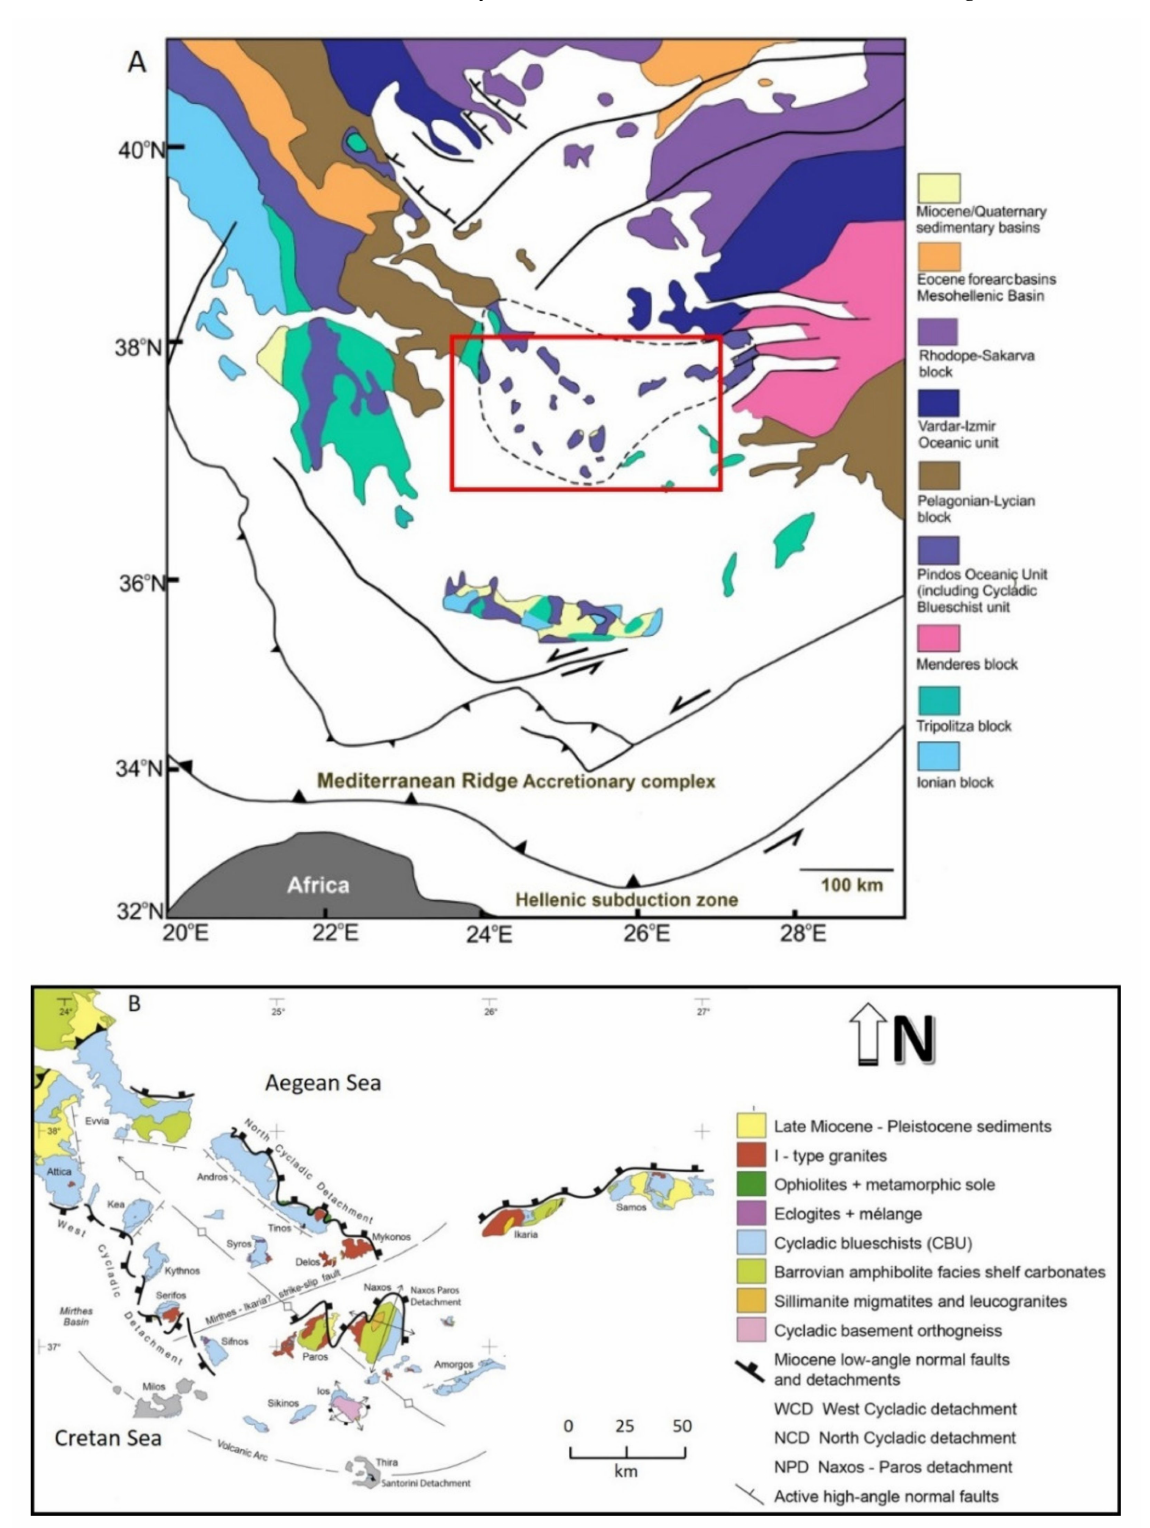
Figure 3. ( A ). A simplified tectonic map showing the major tectonic zones above the Hellenic subduction zone of the Aegean region (modified after [28,29]), ( B ). Simplified geological map of the Attic-Cycladic Crystalline Belt, showing the major tectonic units [28]